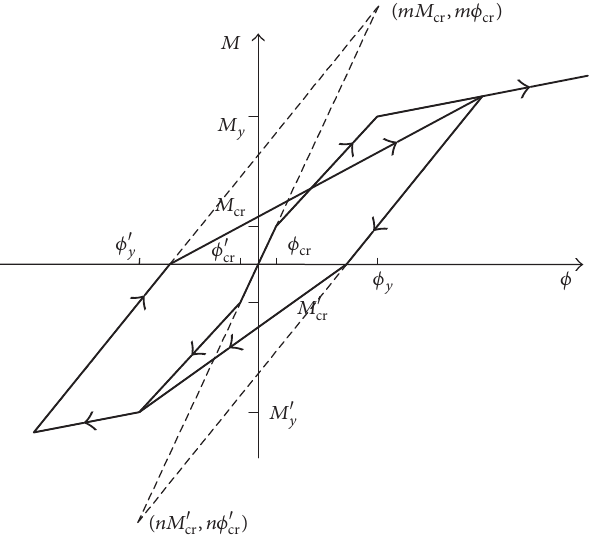
Figure 6: NosaCAD trilinear moment-curvature hysteretic model.